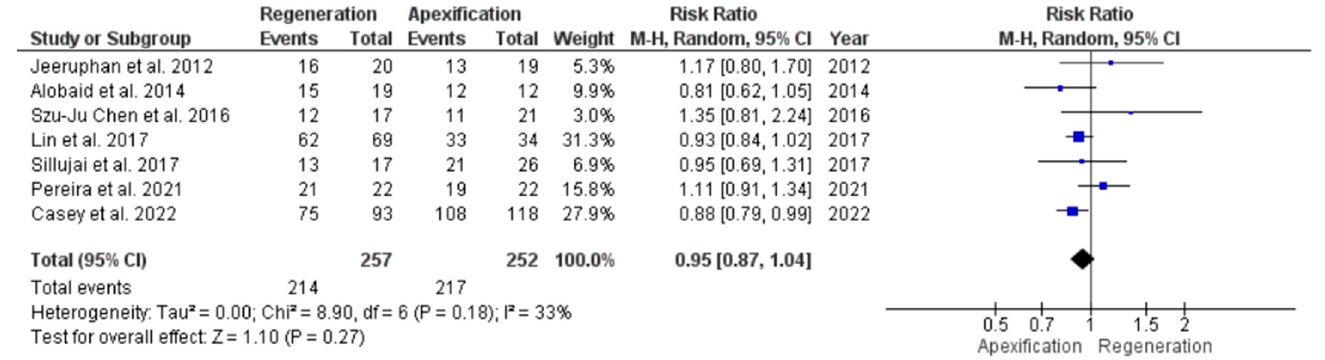
Figure 11. Meta-analysis of success rate in young immature permanent teeth undergoing regenerative endodontic procedure (REP) or apexification procedure.